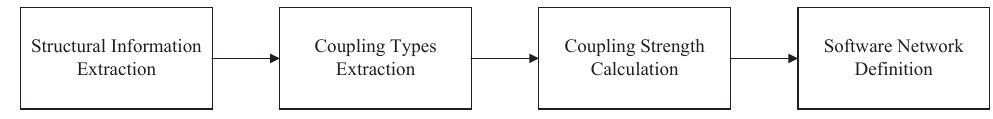
Figure 2. The definition process of a software network (SN)